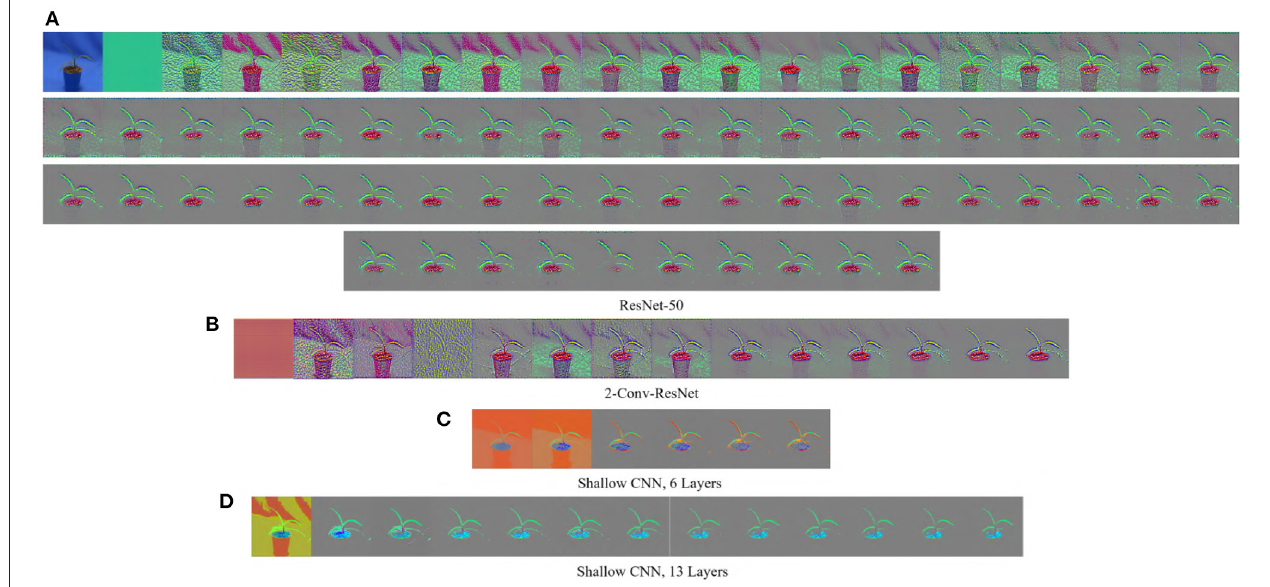
FIGURE 1 | GBP-based visualization of the intermediate layers (left to right) of different CNN models for Barnyard Grass of the Weedling dataset. The top-left image of (A) is the input image for all models. (A) ResNet-50. (B) 2-Conv-ResNet. (C) Shallow CNN, 6 layers. (D) Shallow CNN, 13